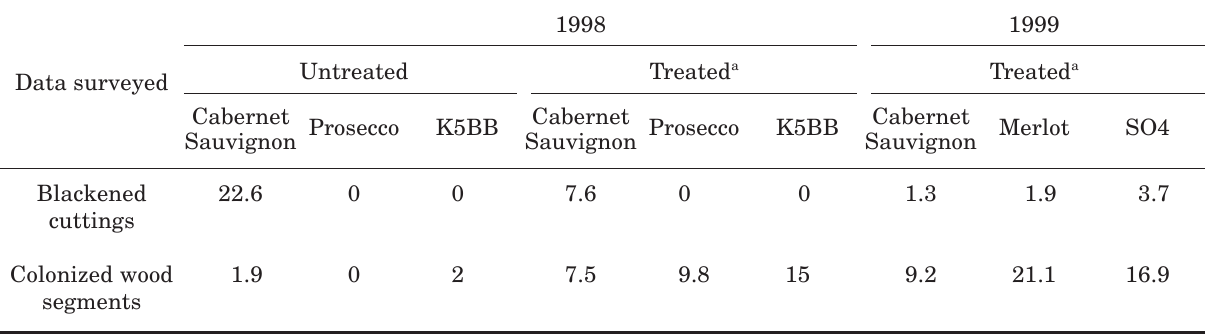
Table 1. Percentage of rootstock (K5BB, SO4) and scion (Cabernet Sauvignon, Prosecco, Merlot) cuttings with wood blackening and percentage of wood sections colonized by fungi in a two years trial (1998,